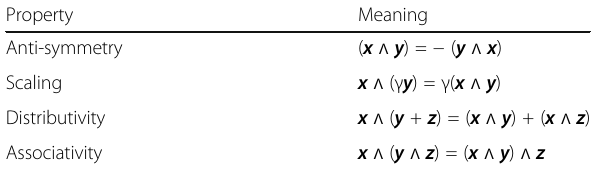
Table 1 Properties of the outer product